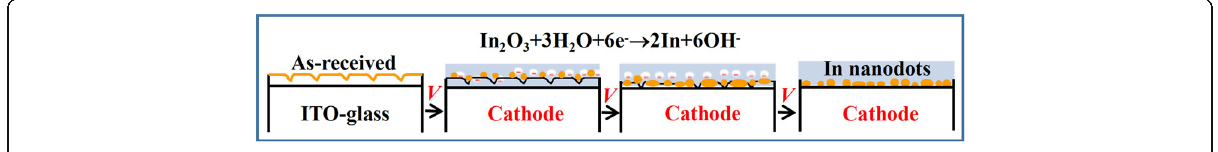
Fig. 2 Schematic illustration of the formation process of In NDs from electrolysis of ITO